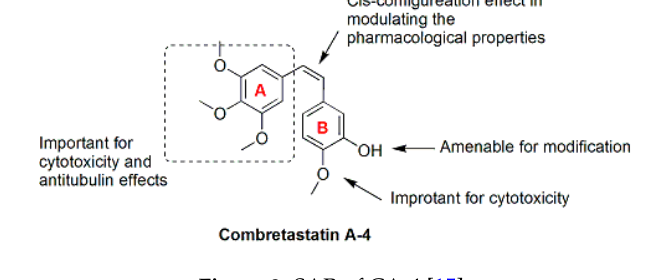
Figure 3. SAR of CA-4 [15].